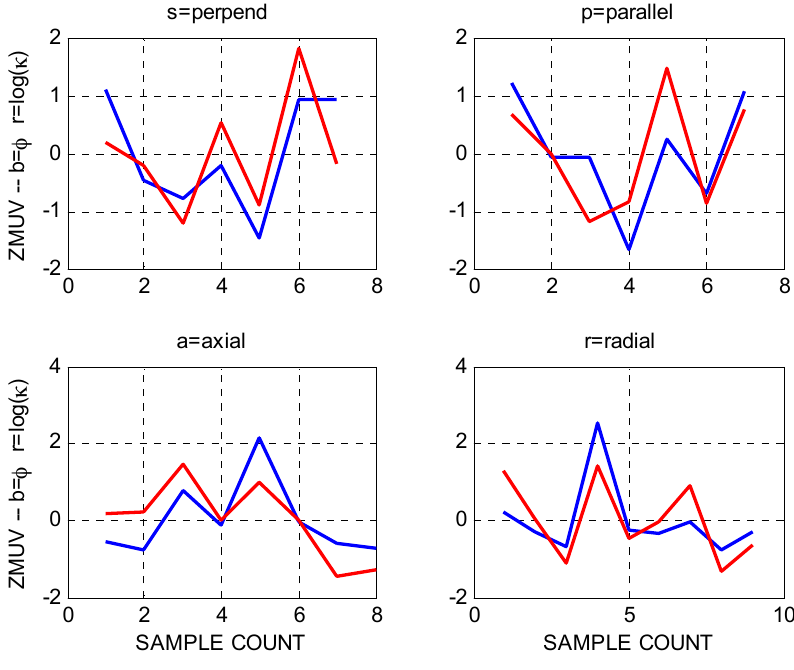
Figure 23. Sample Outokumpu well-log sonic-velocity spectral scaling S(k) ~ k β , β ~ 1.2 ± 0; depths 950–1500 m and 1900–2500 m [28].